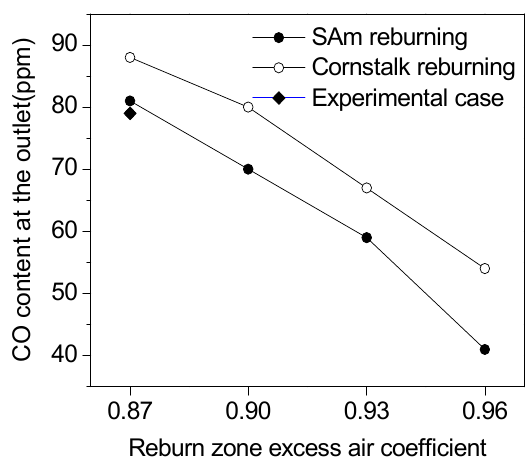
Figure 5. CO content under different α .